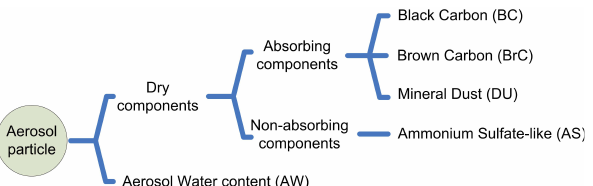
Fig. 3. Aerosol component model used in the chemical composition